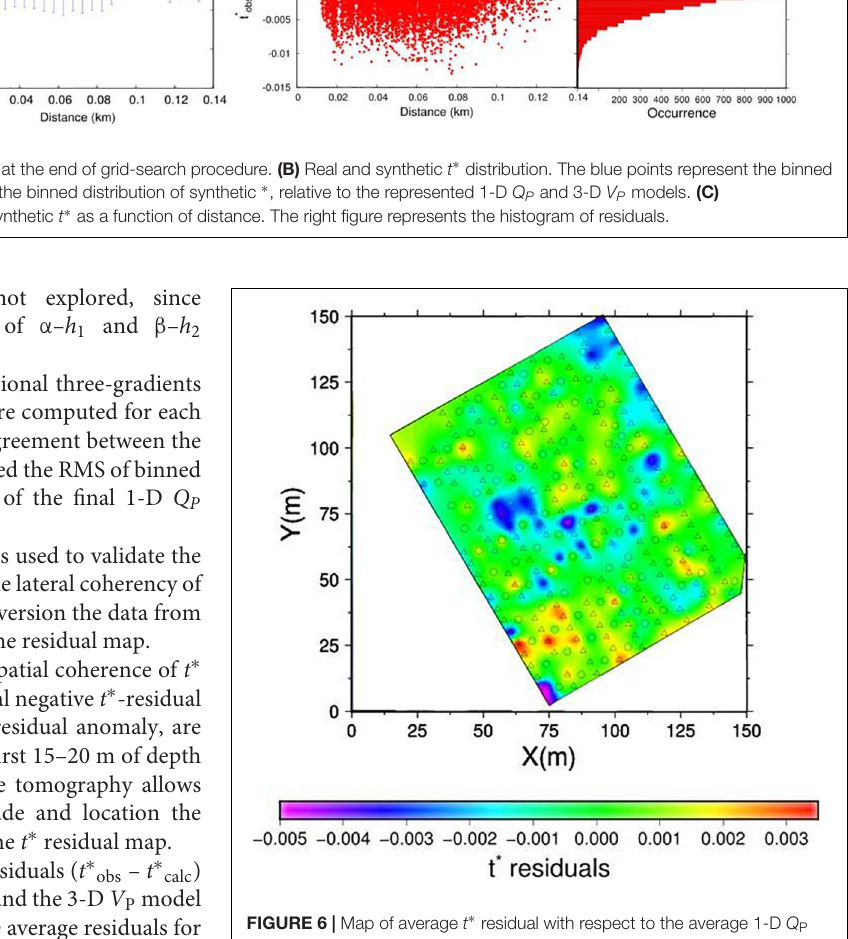
FIGURE 6 | Map of average t ∗ residual with respect to the average 1-D Q P model retrieved from the grid search procedure, computed over all stations and sources. The circles and the triangles represent the position of sources and stations,